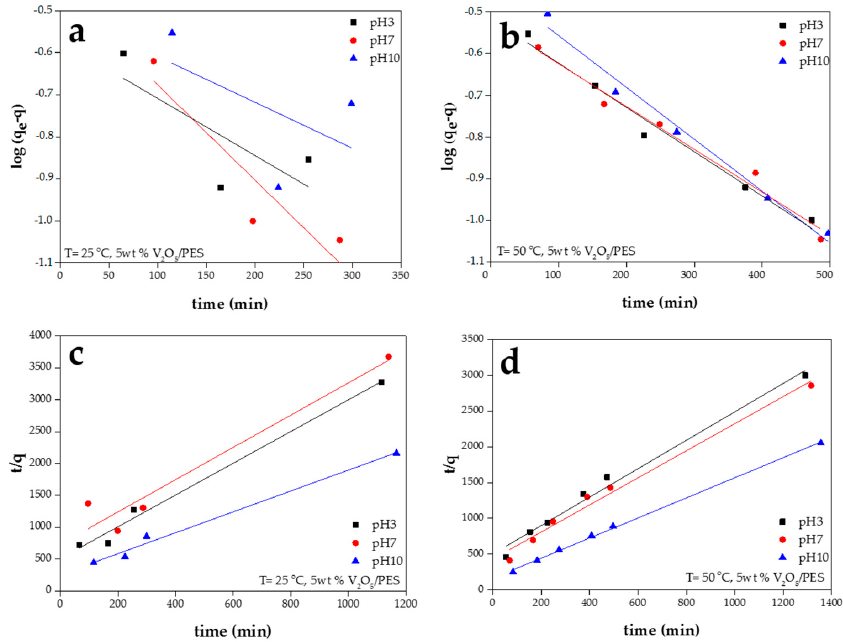
Figure 4. Plots of 1st ( a , b ) and 2nd order ( c , d ) kinetic models of MB adsorption onto the (5 wt %) V 2 O 5 /PES ENAs (plot a clearly implies lack of harmony of the adsorbent system at the low temperature of 25 °C with the Lagergen model). Table 3. Comparison of the first- and second-order adsorption kinetic models for the PES ENAs (exp and cal denote experimental and calculated amounts of dye adsorbed at equilibrium ( q e ), respectively). 1st Order Parameter